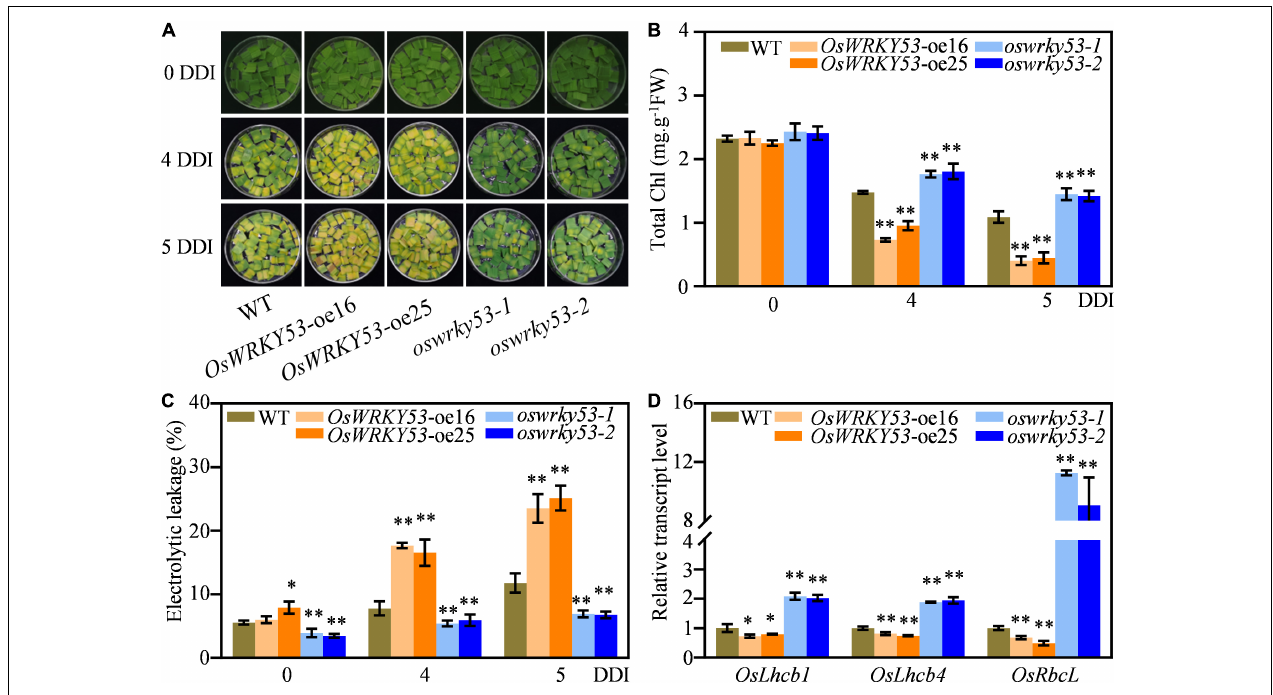
FIGURE 3 | Overexpression of OsWRKY53 promotes dark-induced senescence. (A) Phenotype of detached flag leaf of OsWRKY53 -oe, oswrky53, and wild type (WT) at the booting stage after dark treatment. (B) Chlorophyll content of detached flag leaf of OsWRKY53 -oe, oswrky53, and WT after dark treatment. (C) Ion leakage analysis of detached flag leaf of OsWRKY53 -oe, oswrky53, and WT after dark treatment. (D) Relative transcript levels of photosystem-related genes or chlorophyll biosynthetic gene in detached flag leaf of OsWRKY53 -oe, oswrky53, and WT after 5 DDI. DDI, day of dark incubation. Data represent mean ± SD. Asterisks indicate a significant difference between transgenic plants and WT determined by two-tailed Student’s t -test at ∗∗ p < 0.01 or ∗ p <